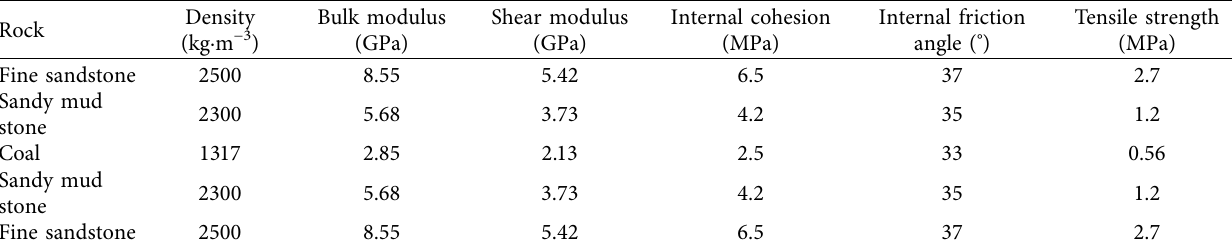
Table 1: Physical and mechanical parameters of each rock